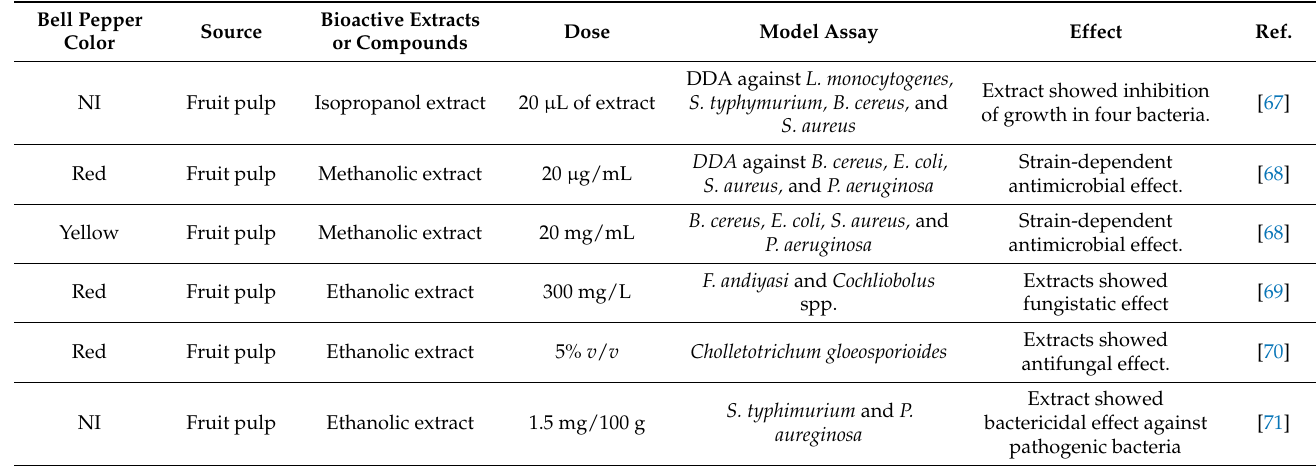
Table 5. Antimicrobial activity of bell pepper